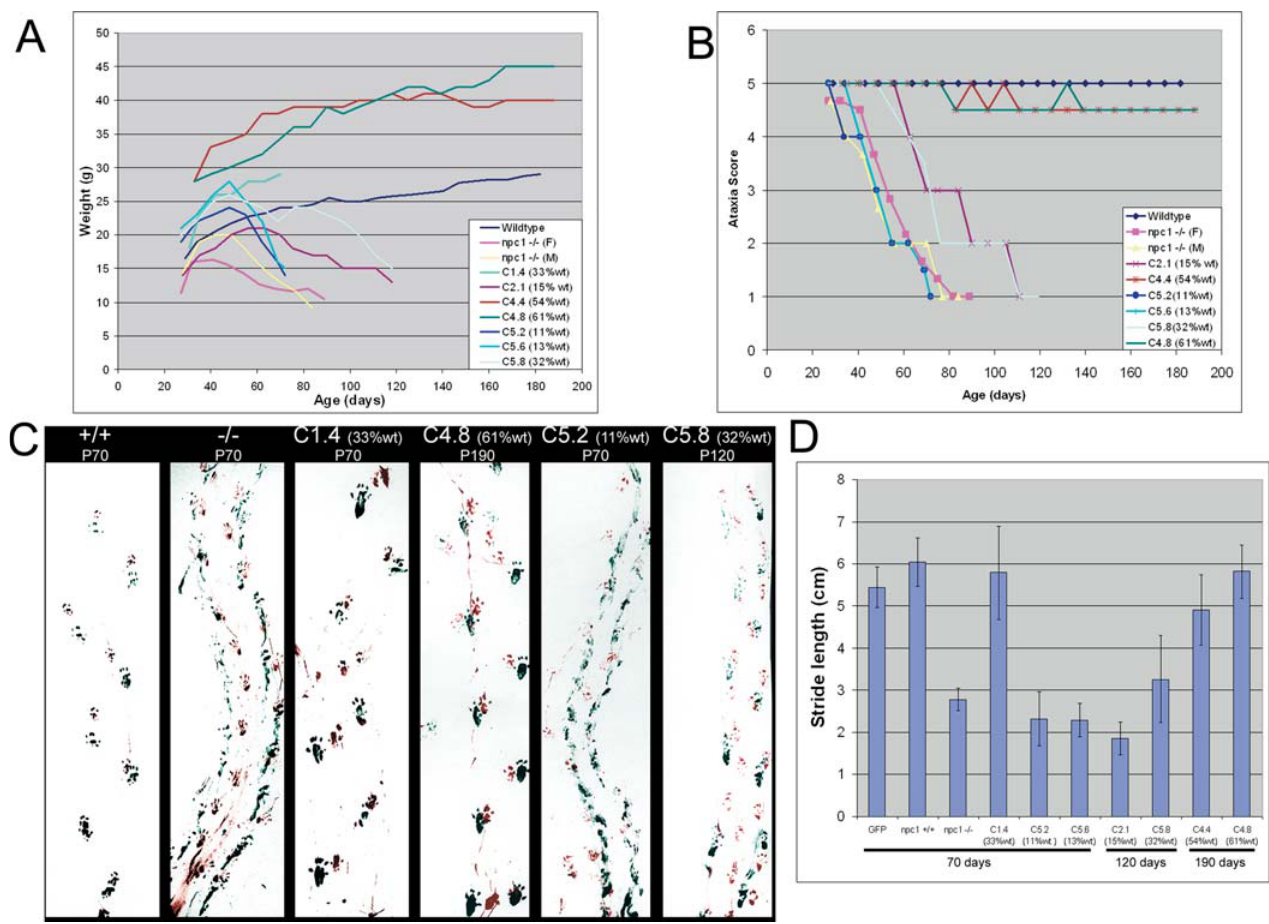
Figure 5. Organismal Phenotypes in Chimeric Mice (A) Chimeric mice with more than 50% wild-type contribution do not exhibit wasting. Weekly weights for each of the mice were recorded from 4 wk until the mice were sacrificed. For wild-type and npc1 (cid:1) / (cid:1) homozygous mice, the curve shown is the mean weight from three to four mice. A progressive decrease in weight of npc1 mice begins to show around 7 wk. The chimeric mice display a delay in, or even absence of, wasting depending on the amount of wild-type contribution. (B) Prevention of ataxia in chimeric mice. Mice were assessed for ataxia weekly during two 3-min trials on a balance beam (see Materials and Methods). (C) Gait of chimeric mice. Front and back paws of mice were dipped in red or green paint, and mice walked across a box lined with paper. The npc1 (cid:1) / (cid:1) mouse displays shorter stride length and a smearing of the footprints as the paws are not as well lifted between steps. Chimeric mice with high amounts of wild-type contribution (C4.8; C4.4 not shown) exhibited a gait indistinguishable from wild-type. (D) Quantification of stride length. For wild-type and mutant controls, three mice were assessed. For chimeric mice, gait was measured prior to sacrifice at the ages noted. Error bars indicate the standard deviation. Comparison with the GFP mice demonstrates that npc1 þ / þ , C1.4, C4.4, and C4.8 do not have significantly different stride lengths ( p . 0.05) while npc1 (cid:1) / (cid:1) , C5.2, C5.6, C2.1, and C5.8 have significantly shorter stride lengths ( p , 0.001) DOI: 10.1371/journal.pgen.0010007.g005 In addition to surrounding glial cells, the health of PCs sible for PC death. Microglia produce pro-inflammatory and could be affected by their axonal targets in the cerebellar cytotoxic compounds including cytokines, proteases, and free deep nuclei. Expression of GFP is very low in neurons of the radicals [55–57] and are present in higher-than-normal cerebellar deep nuclei in the GFP mice (data not shown), so numbers in the NPC mutant cerebellum [28]. A robust we were unable to assess the genotype of these cells in the chimeras. During the migration of PCs, their axons do not remain attached to their future post-synaptic targets [52]. If PC death in npc1 mice was caused by loss of a target-derived factor, then the absence of a genotypic match between target neurons and PCs would mean that wild-type and npc1 PCs should be equally affected. This is not what we observe. In addition, completely depriving PCs of their axonal targets by axotomy does not cause PC degeneration even up to a year normally seen at postnatal day 3 [58]. A microglia-based following axotomy [53,54]. Thus, derangement of cerebellar mechanism would require a cell-autonomous component— deep nuclei is unlikely to be causing PC degeneration in NPC. Secreted or released toxic molecules are also not respon- PCs expressing the proper membrane receptors—and a non- PLoS Genetics |